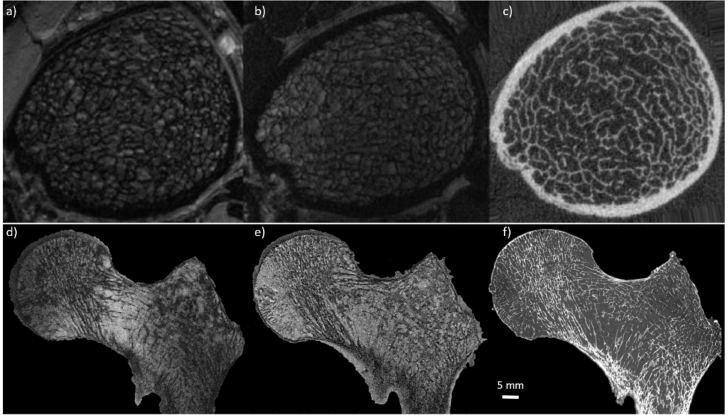
Figure 1. Comparison between MRI and CT. (first row) MR images of in vivo distal tibia acquired using gradient echo sequence at 7T MRI ( a ) (0.156 mm × 0.156 mm × 0.5 mm) and 3T MRI ( b ) (0.156 mm × 0.156 mm × 0.5 mm), and compared with high-resolution peripheral computed tomography (HR-pQCT) ( c ) (0.082 mm 3 ) (reproduced from J. of Mag. Res. Im. 27:854–859 (2008)). (second row) MR images of cadaveric proximal femur acquired using turbo spin echo sequence at 7T MRI ( d ) (0.13 mm × 0.13 mm × 1.5 mm) and 3T MRI ( e ) (0.21 mm × 0.21 mm × 1.1 mm), and compared with µ CT ( f ) (0.051 mm 3 ). Note that using MRI, the trabecular bone appears black and bone marrow delivers the bright signal whereas for HR-pQCT and µ CT the trabecular bone is shown bright. Additionally, note that the trabecular network is clearly more enhanced at 7T compared to